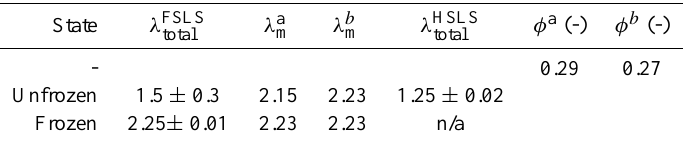
Fig. 6. (a) The model and its units. The temperature field based on the steady-state simulations using (b) the mean value, (c) lower thermal conductivity, and (d) higher thermal conductivity. The vertical scale is greatly exaggerated. Table 1. Summary of the different measured thermal conductivity values λ (Wm − 1 K − 1 ) of the sample No. 28(2) from the permafrost borehole 5011-3. φ is porosity, which can be estimated from the ratio of volume and mass of the sample ( φ a ), or from thermal conductivity ( φ b ). Based on these, the corresponding matrix thermal conductivities λ a,b m can be determined. FSLS: full-space line source, HSLS: half-space line